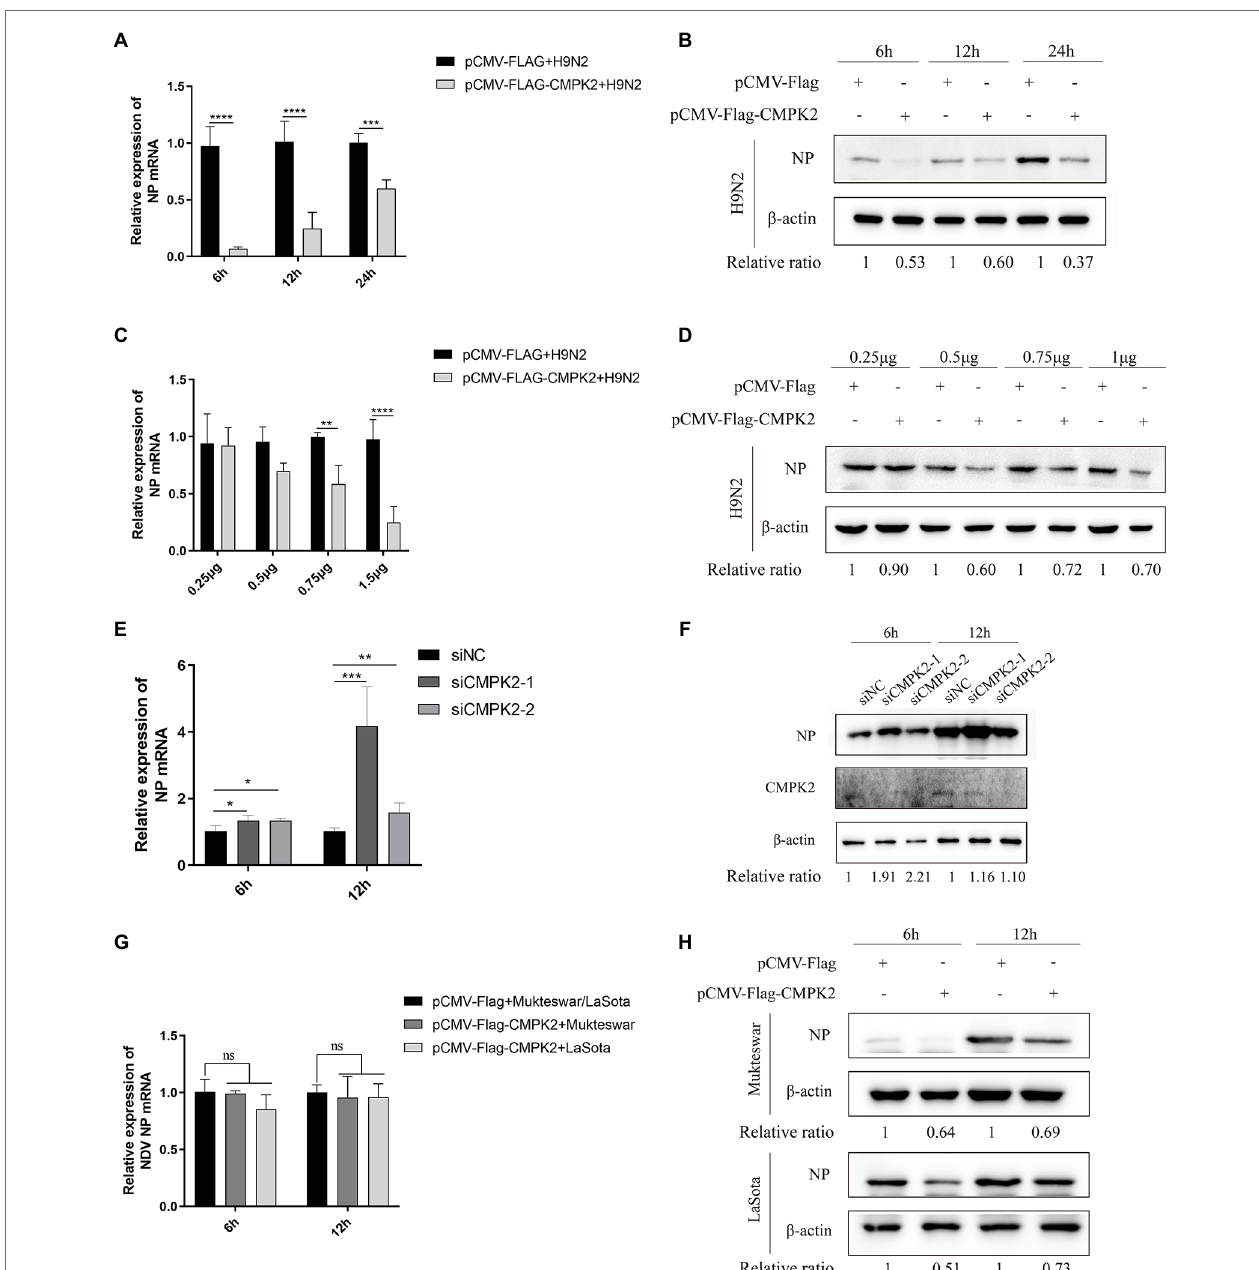
FIGURE 7 | Antiviral effects of chCMPK2 on AIV and NDV. DF-1 cells were transfected with pCMV-Flag-CMPK2 or pCMV-Flag (control) for 24 h and then infected with AIV H9N2 at an MOI of 0.1 for 6, 12, and 24 h. The expression levels of H9N2 NP were detected by qRT-PCR (A) and WB (B) assays. DF-1 cells were transfected with pCMV-Flag-CMPK2 at different doses (0.25, 0.5, 0.75, and 1.5 μ g) for 24 h and then infected with H9N2 at an MOI of 0.1 for 6 h. The expression levels of H9N2 NP were detected by qRT-PCR (C) and WB (D) assays. DF-1 cells transfected with CMPK2 siRNAs or siRNA-NC were infected with H9N2 at an MOI of 0.1. After 6 and 12 h, H9N2 viral NP levels in infected DF-1 cells were measured by qRT-PCR (E) and WB (F) . DF-1 cells were transfected with pCMV-Flag-CMPK2 or pCMV-Flag (control) for 24 h and then infected with NDV strains LaSota and Mukteswar at an MOI of 0.1 for 6 and 12 h. The expression levels of NDV NP were detected by qRT-PCR (G) and WB (H) . The gray intensity for each band was measured, and the relative ratio of AIV NP was determined from the equation (Sample NP /Sample actin )/(Mock NP /Mock actin ) and marked at the bottom of each lane. Values represent the mean of the individual measurements in each sample ± SEM. * p < 0.05, ** p < 0.01, *** p < 0.001, and **** p <